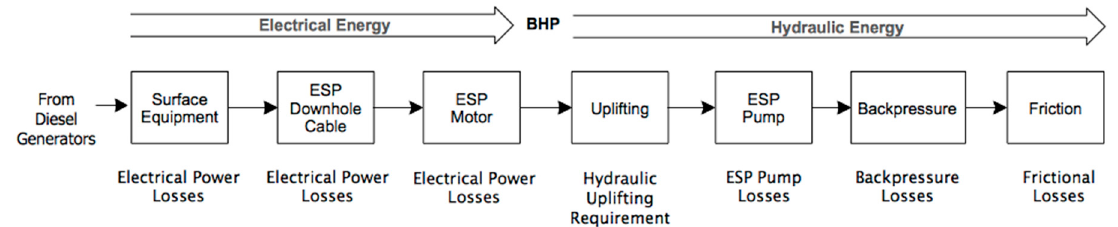
Figure 6. Electrical and hydraulic components of an ESP system.